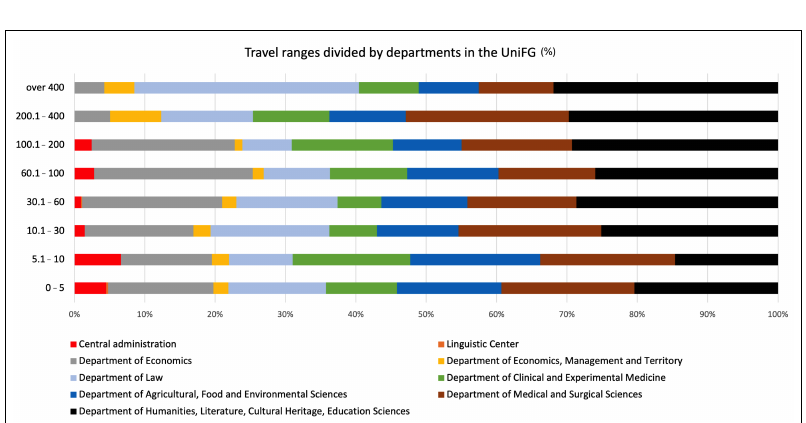
Figure 11. Kilometers traveled by respondents for role and